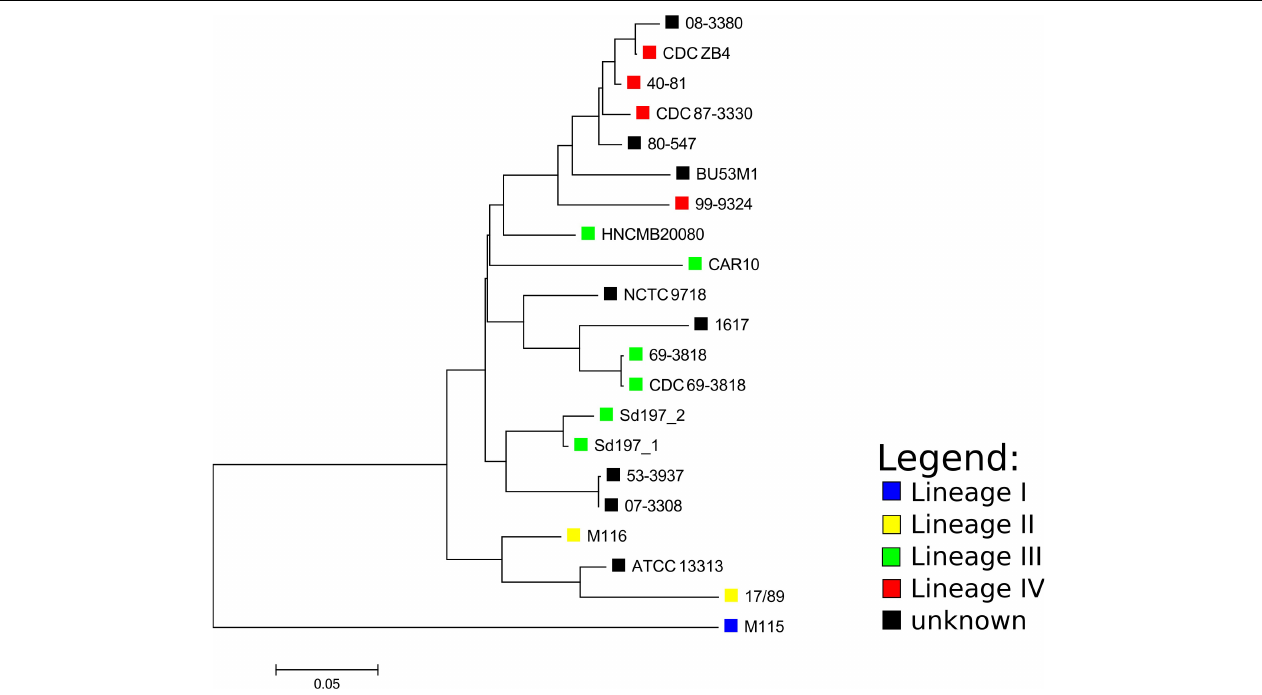
FIGURE 1 | Core SNP-based phylogenetic tree of Shigella dysenteriae complete genomes and Pacbio determined assemblies made with ASA 3 P. The SNP analysis was performed with ParSNP, followed by removal of SNPs at recombination sites by Gubbins. The tree was visualized with MEGA. The lineages designated for strains by the SNP-based phylogeny made by Njamkepo et al. (2016) are marked with colored squares where applicable.